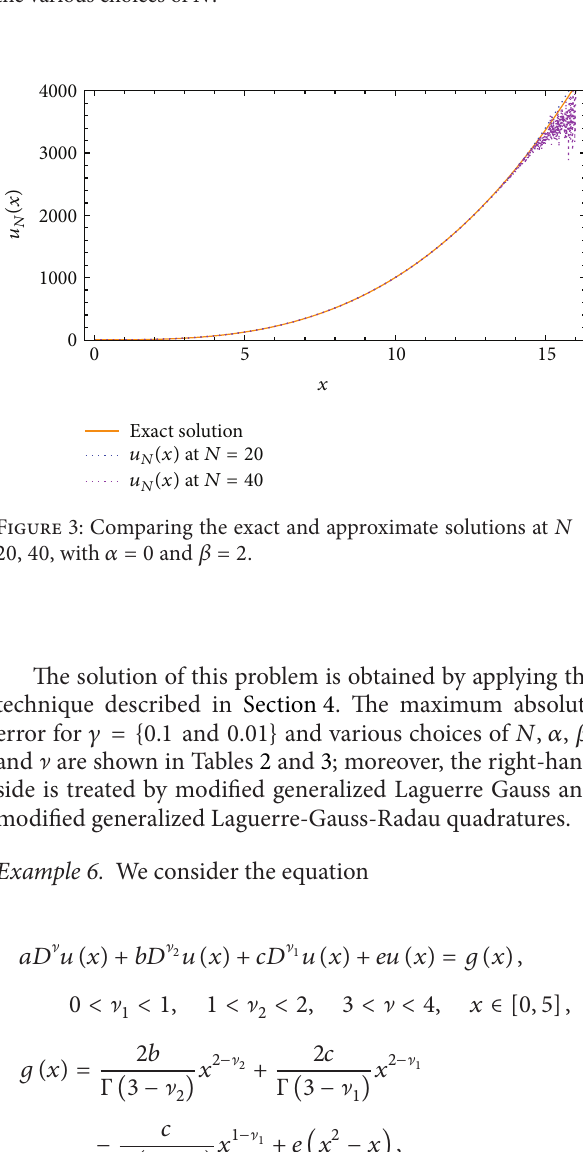
Figure 2: Maximum absolute error by using MGLT (Radau) with the various choices of 𝑁 .